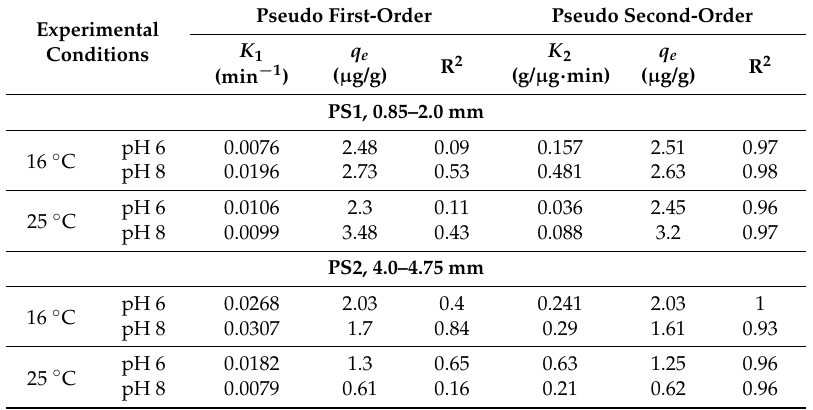
Table 5. Kinetic parameters for adsorption of CBZ onto tezontle at different experimental conditions.